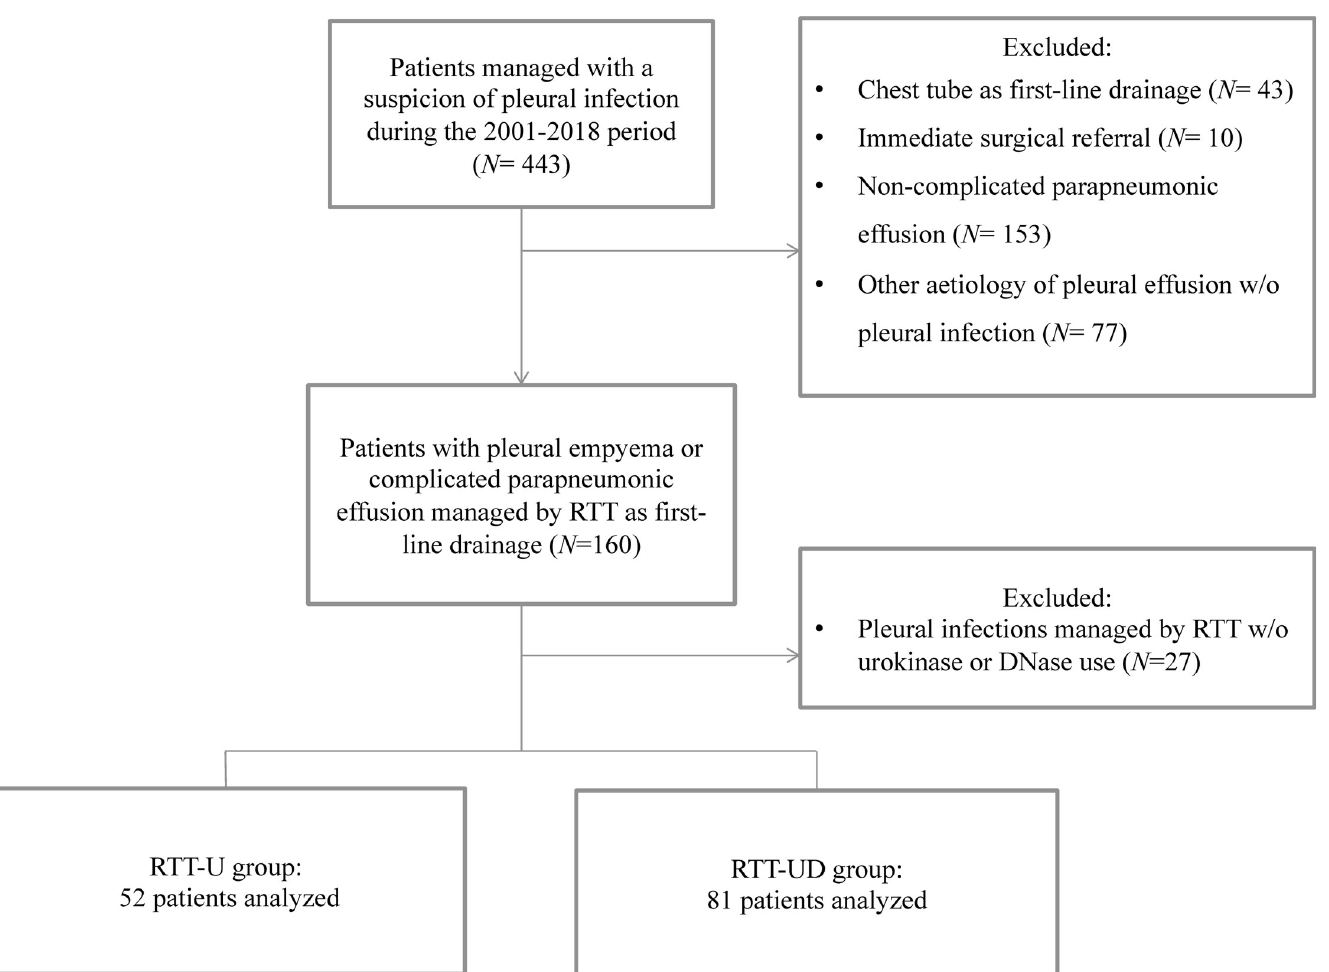
Fig 1. Flowchart of the study. RTT-U: Repeated therapeutic thoracenteses with use of intrapleural urokinase only. RTT-UD: Repeated therapeutic thoracenteses with use of intrapleural urokinase and DNase.